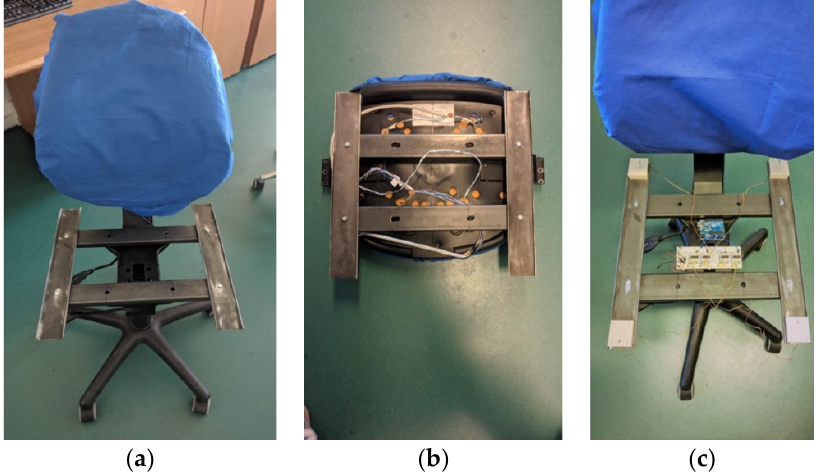
Figure 2. Custom frame realized to house the load cells: ( a ) first part of the new frame fixed on the chair structure; ( b ) second part of the new frame fixed under the seat; ( c ) load cells housing. The load cells used in this project are the FX1901 class (Measurement Specialties